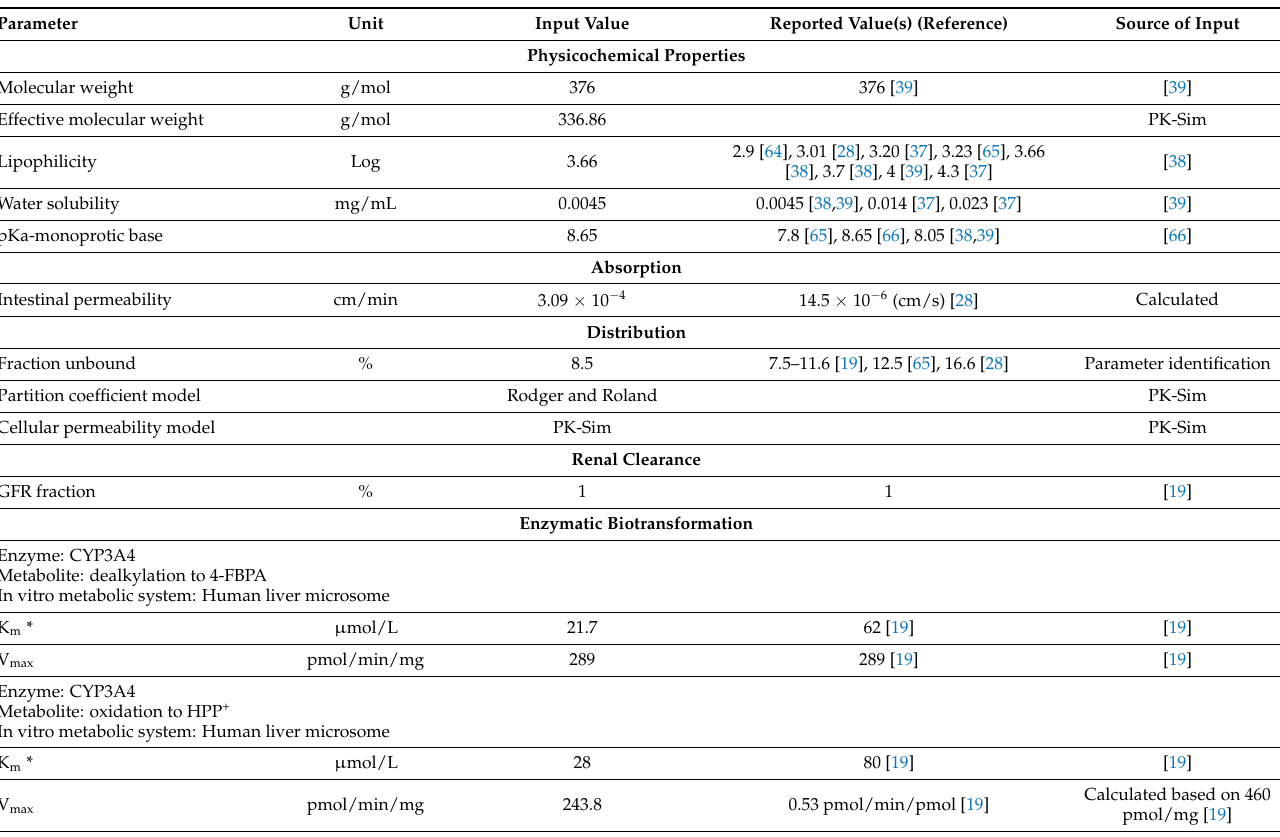
Table 2. Input parameters used to build the haloperidol PBPK